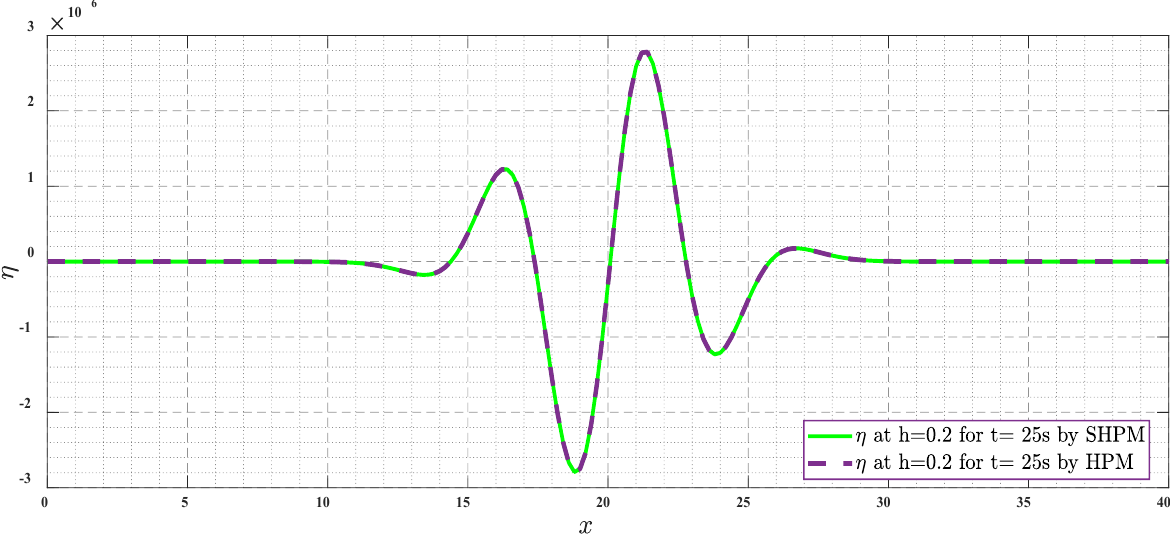
Figure 12. WSE ( η ) by SHPM and HPM at t = 25 s ( h = 0.2).